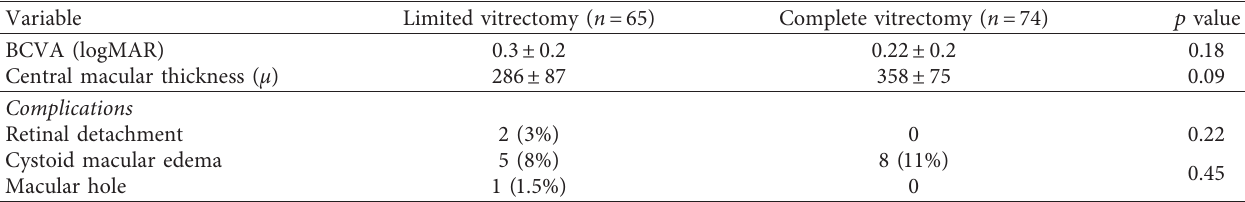
Table 4: Complications and outcomes of limited versus complete vitrectomy at the end of a 6-month